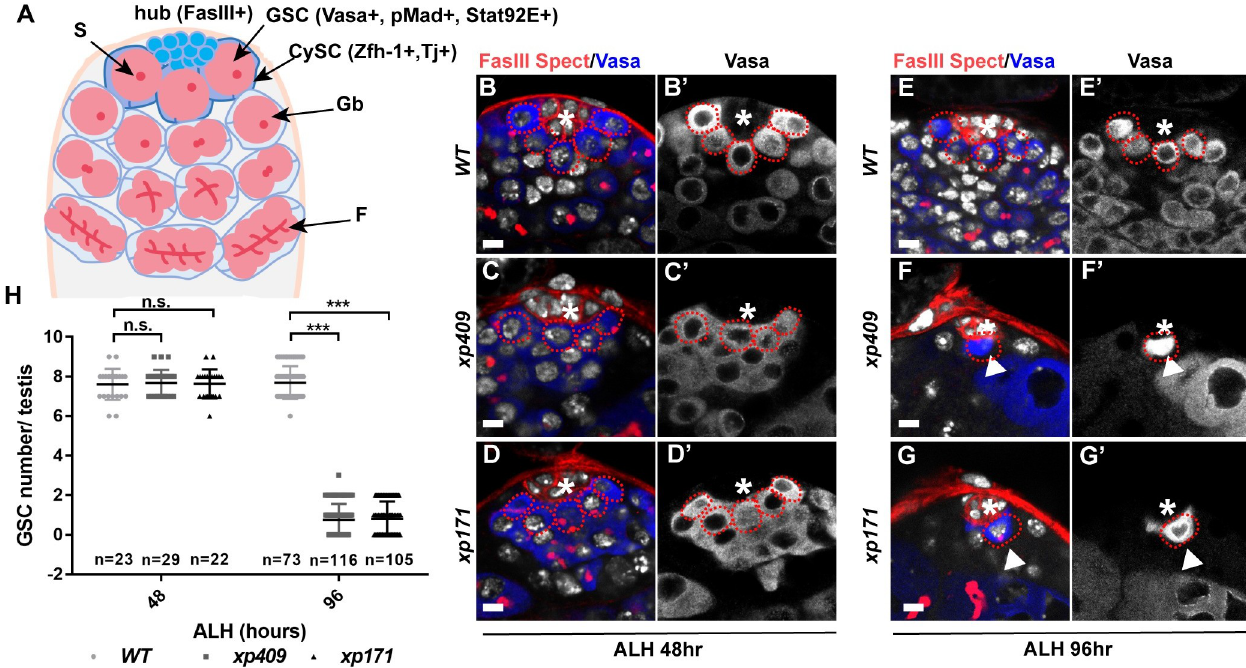
Fig 1. dRTEL1 plays a crucial role in GSC maintenance in Drosophila larval gonad. (A) A schematic diagram showing the anterior tip of Drosophila testis. (B-G) Representative confocal images of GSCs in Drosophila larval testis. ToPro-3 in white. Wild-type (control) testes maintain similar number of GSCs at